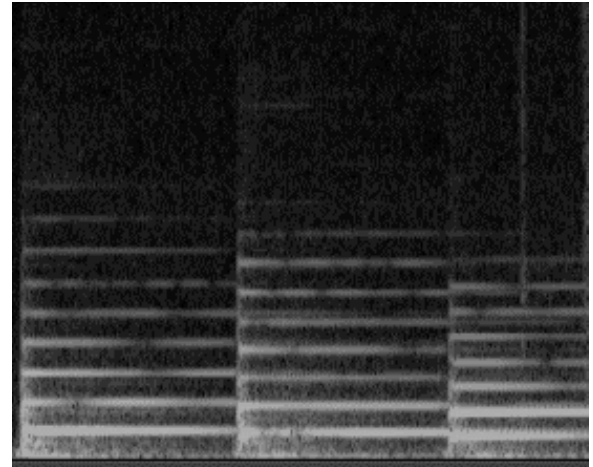
Figure 22. The spectrogram of the signal restored by five components.